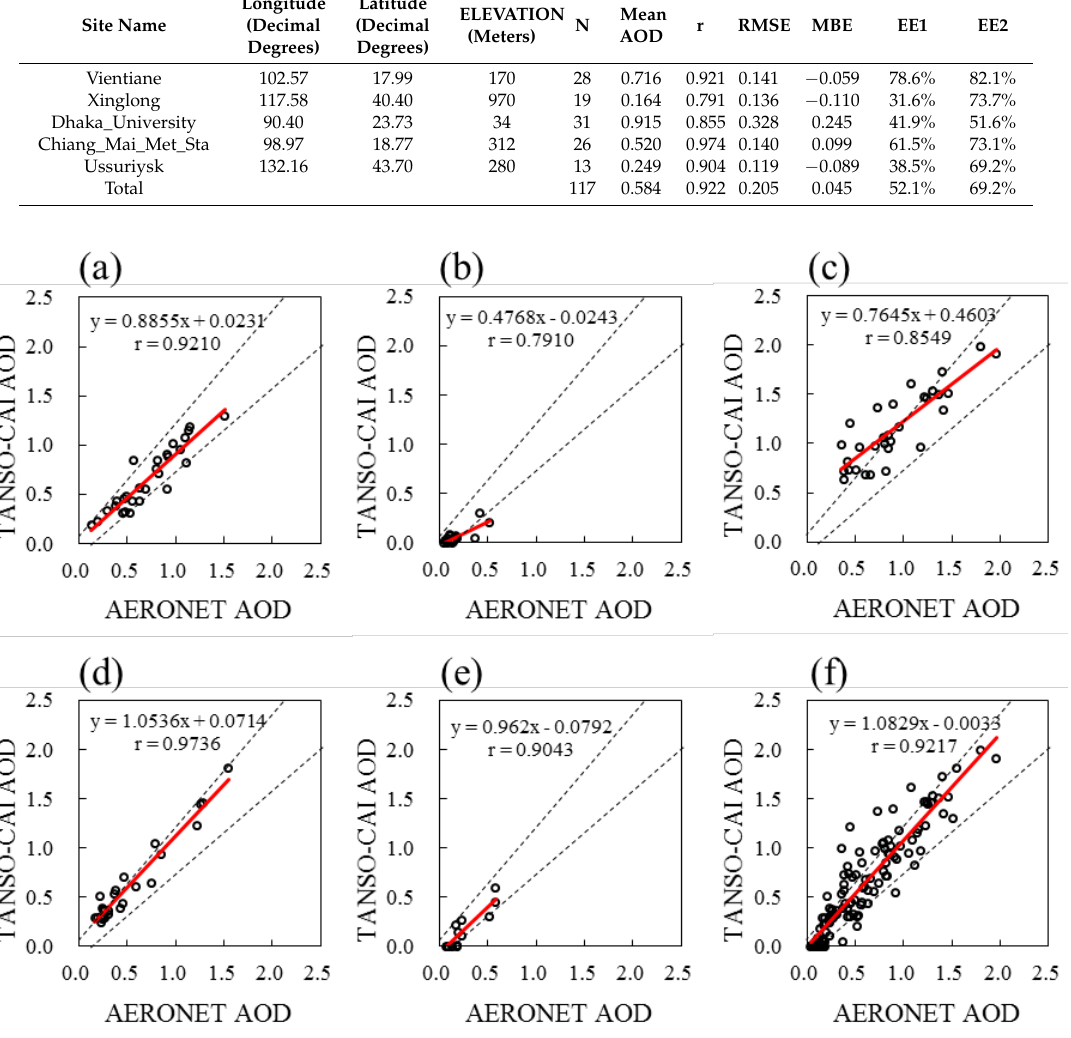
Figure 11. Validation of TANSO-CAI retrievals against AERONET measurements over different regions. ( a ) Vientiane site; ( b ) Xinglong site; ( c ) Dhaka_University site; ( d ) Chiang_Mai_Met_Sta site; ( e ) Ussuriysk site; and ( f ) for all sites. The red solid and dashed lines are the regression line and the expected error (±(0.1 + 15% AOD AERONET )) envelope line, respectively. Table 4. Geographical information and summary statistics for the entire data set and each individual site: longitude, latitude, elevation, number of samples (N), correlation coefficients (r), root mean square errors (RMSE), mean bias errors (MBE), and expected errors (EE).